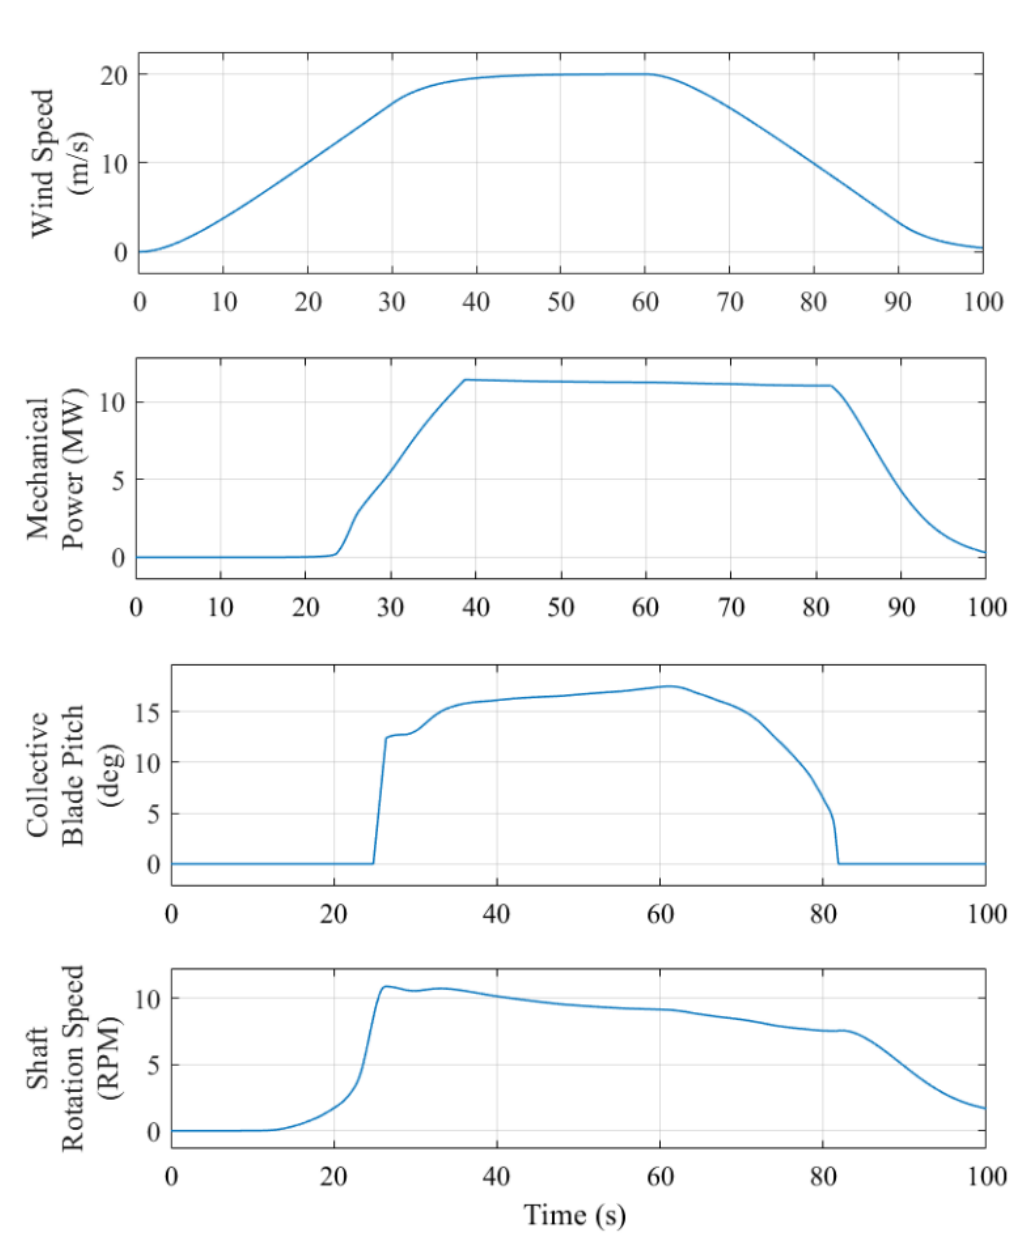
Table 1. 10 MW direct drive wind turbine parameters. These parameters are based on [24,31,32].